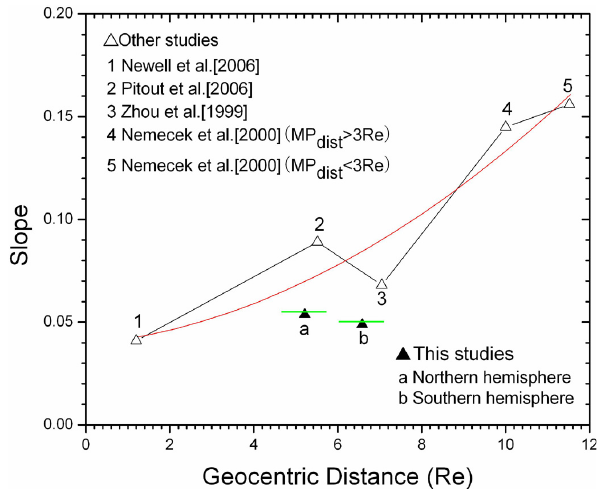
Fig. 4. The dependence of cusp location on the dipole tilt angle in different studies. Here we noted that point 2 should be lower because it corresponds to the poleward boundary of the